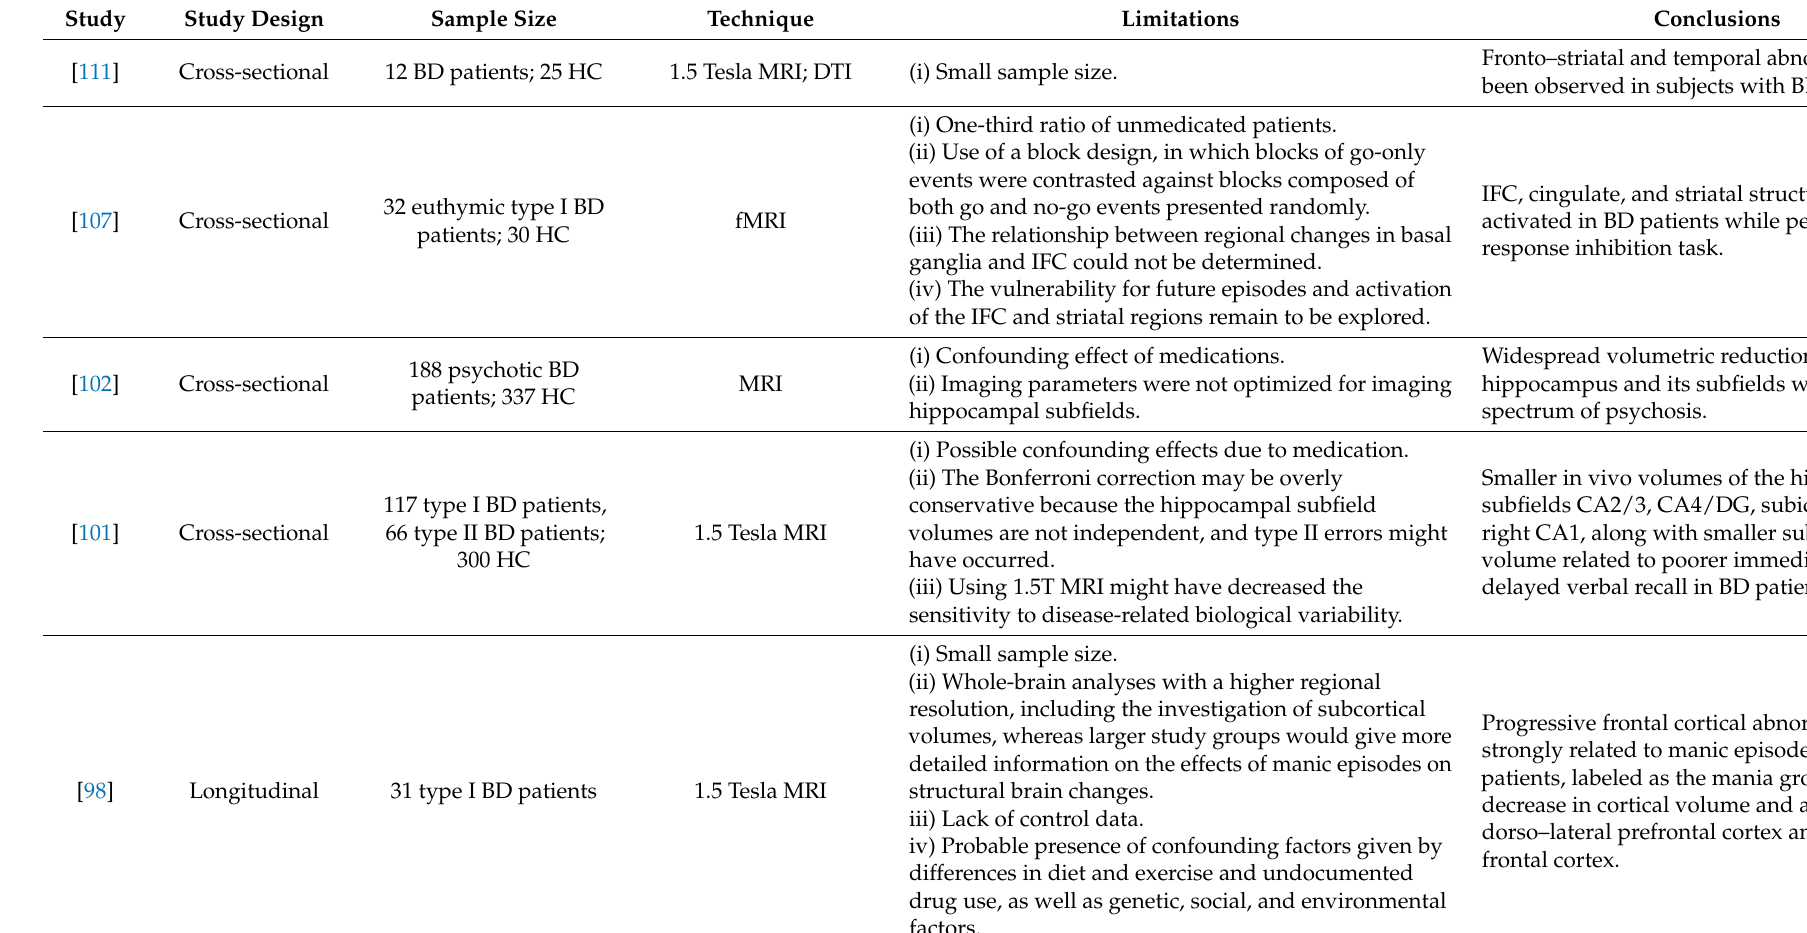
Table 4. Further neurological and imaging correlates supporting the neuroprogressive hypothesis of